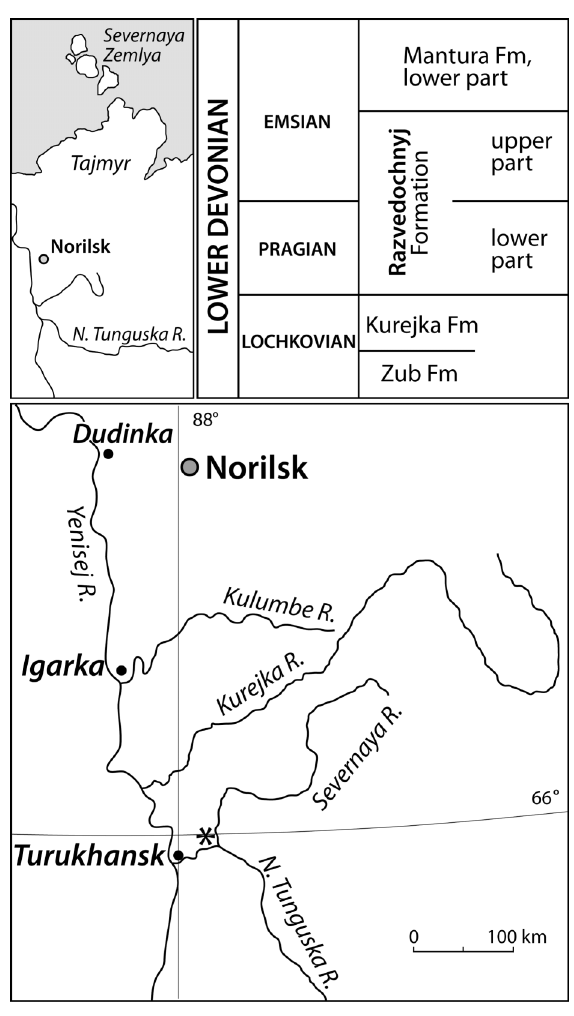
Fig. 1. Sketch maps of northwestern Siberia, Russian Federation; the asterisk * shows the locality of Eukaia gen. nov. On the upper right: subdivisions of the Lower Devonian in the NW part of the Siberian